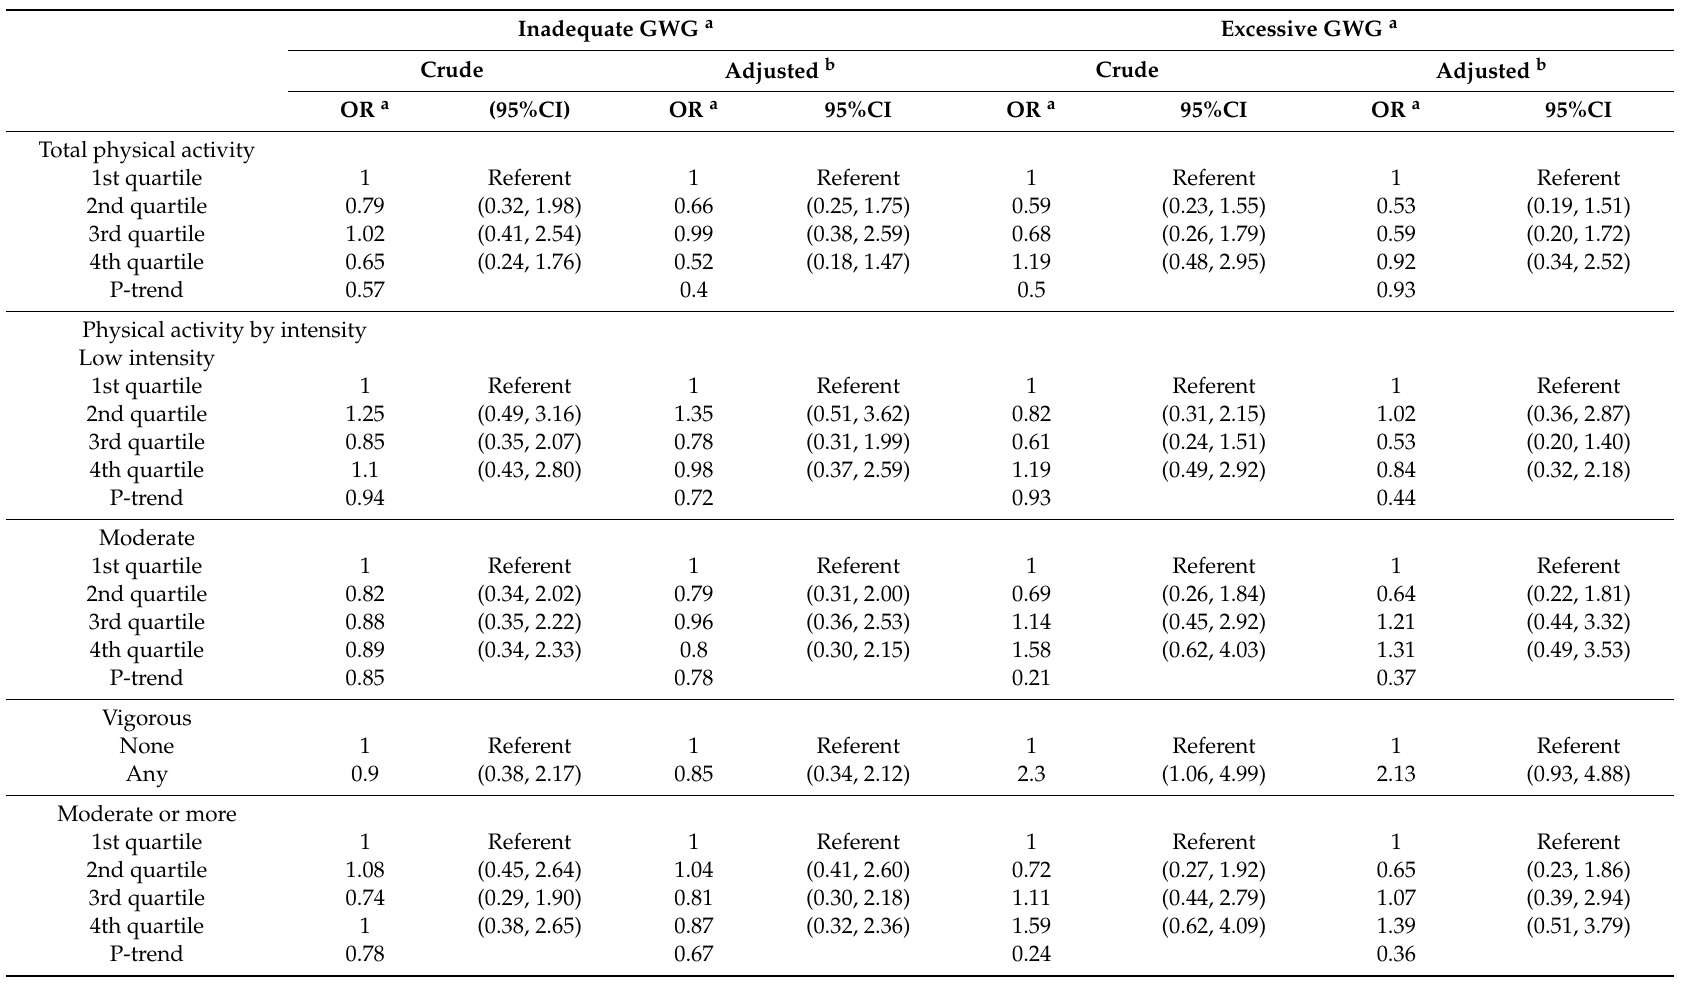
Table 3. The association between second trimester physical activity and gestational weight gain (GWG)